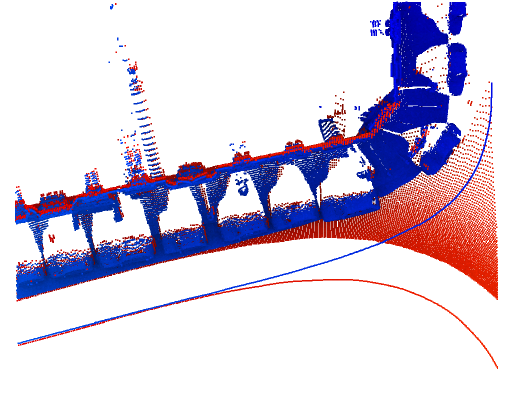
Figure 1: Georeferencing errors between two point clouds (red and blue color). The two trajectories are also visible. Shift can be noticed on cars and buildings facades.